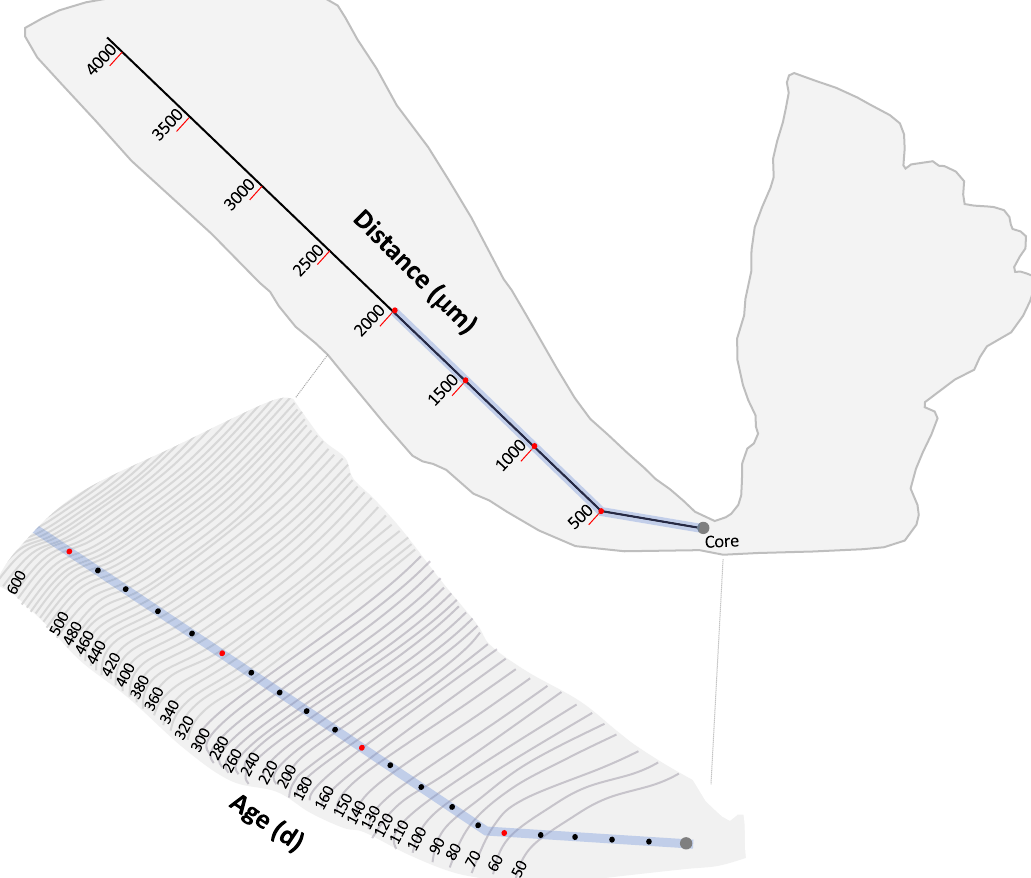
Figure 1. Thin section of Pacific bluefin tuna sagittal otolith displaying location of laser path with green highlighted section of line indicating the portion of the laser scan used to create geochemical profiles (top). Isolated region of otolith thin section corresponding to the geochemical profile along the 2000 µm path was matched to predicted age or days post hatch (dph) from otolith microstructure analysis (bottom). Position of daily increments along the laser scan were estimated for a series of otoliths and grey lines represent estimated age contours at specific intervals Time-resolved intensities from the ICP-MS were converted to elemental concentrations (ppm) equivalents using Iolite software with 43 Ca as the internal standard and a Ca index value of 38.3% weight. Standard base- lines were determined from 30 s gas blank intervals measured while the LA system was off, and all masses were scanned by the ICP-MS. The primary calibration standard used was USGS MACS-3, with the accuracy and pre- cision assessed using replicates of NIST 612 as an unknown. NIST 612 analyte recoveries were typically within 2% of GeoREM preferred values (http:// georem. mpch- mainz. gwdg. de). Concentrations were then converted to element:Ca molar ratios (R E , µmol mol −1 ) based on the molar mass of each element (M E , g mol −1 ) and calcium (M Ca = 43 g mol −1 ): E ] 0.38 R E = [ M E M Ca (cid:30) 1000 (cid:31) Microstructure analysis. The relationship between LA transect distance from the otolith core and inferred age in days post hatch (dph) was determined using a subset of 25 juvenile (~ age-1 +) PBT collected over several months in 2012 by NOAA’s biological sampling program for recreational tuna caught in the California Current Large Marine Ecosystem 22 . For microstructure analysis of daily increments, thin sections required polishing from both sides to a final thickness of approximately 100–200 μm. Daily increments and 15–20 days isolines were marked with ImagePro (Premier) in calibrated images taken at 400 × magnification with a Nikon Eclipse E400 compound microscope. Age contours were then derived via Kriging (Golden Software Surfer 8.0) 22 and later used to infer the likely ages along the core-to-edge laser ablation axis (Fig. 1). Age-specific timing of geochemical shifts along the profile from 0 to 2000 µm (i.e., 0 to ~ 600 + dph) was pre- dicted using a distance from core and age relationship developed from otolith microstructure analysis (Fig. 2). Ages (dph) were estimated along the laser scan path using age contours and matched to distance measures at